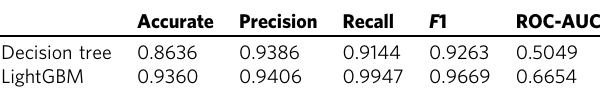
Table 2 Evaluation